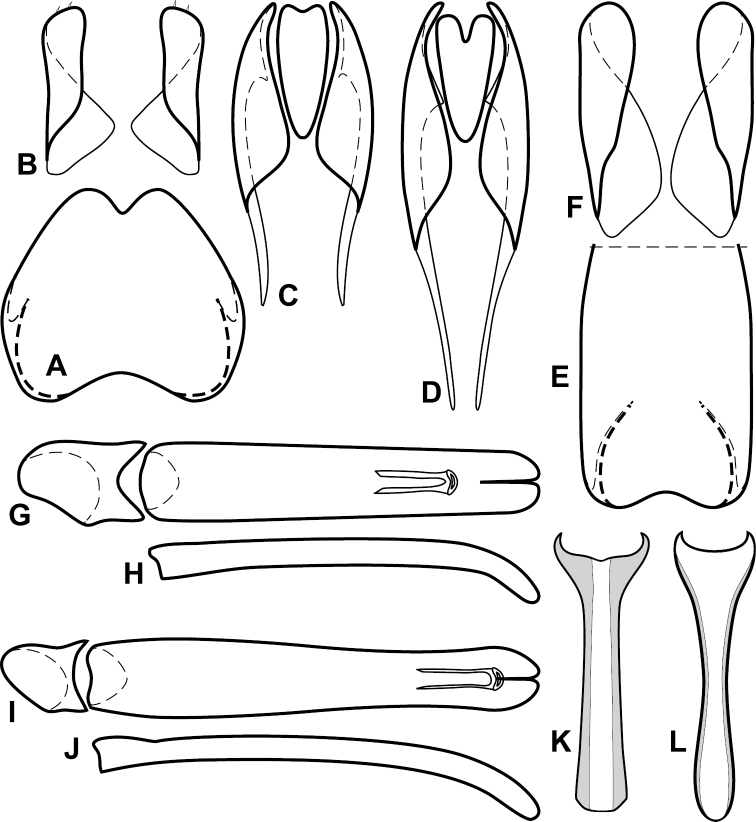
Male genitalia of Baconia famelica group. A T8 of Baconia cavifrons
B S8 of Baconia cavifrons
C T9 & T10 of Baconia cavifrons
D T9 & T10 of Baconia haeterioides
E T8 (apex damaged, not drawn) of Baconia haeterioides
F S8 of Baconia haeterioides
G Aedeagus, dorsal view of Baconia cavifrons
H Aedeagus, lateral view of Baconia cavifrons
I Aedeagus, dorsal view of Baconia haeterioides
J Aedeagus, lateral view of Baconia haeterioides
K S9 of Baconia cavifrons
L S9 of Baconia haeterioides.